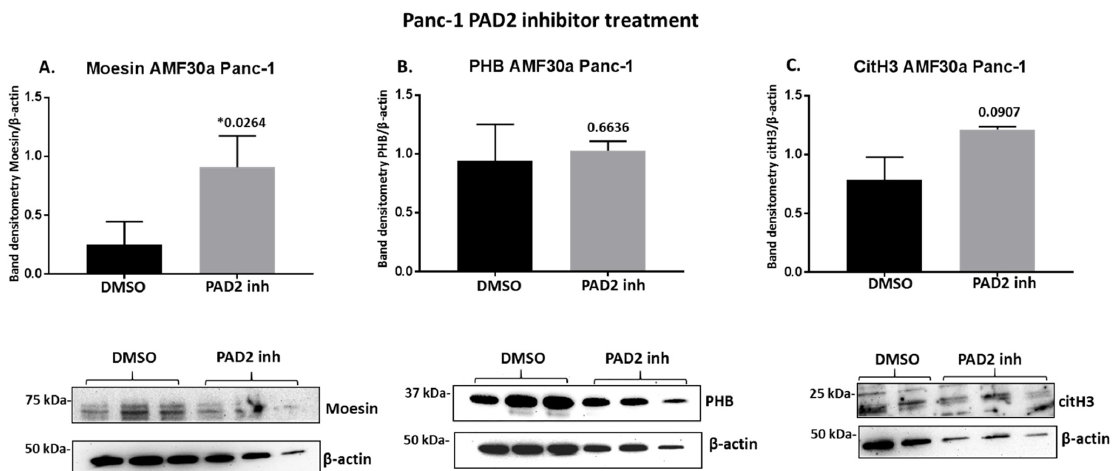
Figure 10. PAD2 inhibitor treatment (1 h) effects on moesin, prohibitin, and citH3 levels in Panc-1 cells. ( A ) PAD2 inhibitor treatment significantly increased Moesin levels in Panc-1 cells. ( B ) No significant effect was observed on PHB levels following 1 h PAD2 inhibitor treatment in Panc-1 cells. ( C ) Histone H3 deimination (citH3) was somewhat increased following 1 h PAD2 inhibitor treatment, but not reaching significance. The error bars show SD, exact p -levels are shown ( * highlights significance at p ≤ 0.05), and representative Western blots are shown for all protein assessments. The histograms are based on n = 3 per treatment.